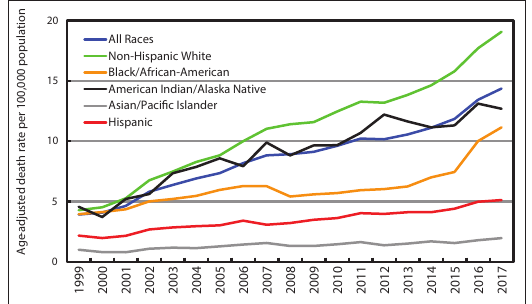
Figure 4: Racial/Ethnic Trends in Drug Overdose Mortality, Females, United States, 1999-2017 Source: Data derived the National Vital Statistics System, Nation - al Mortality Database.